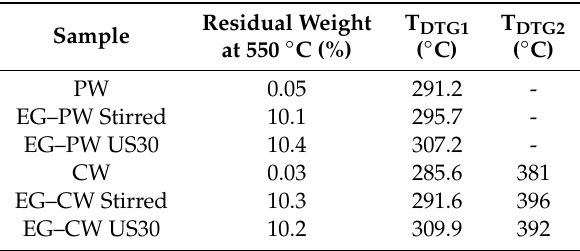
Table 2. TGA results for the CW and PW